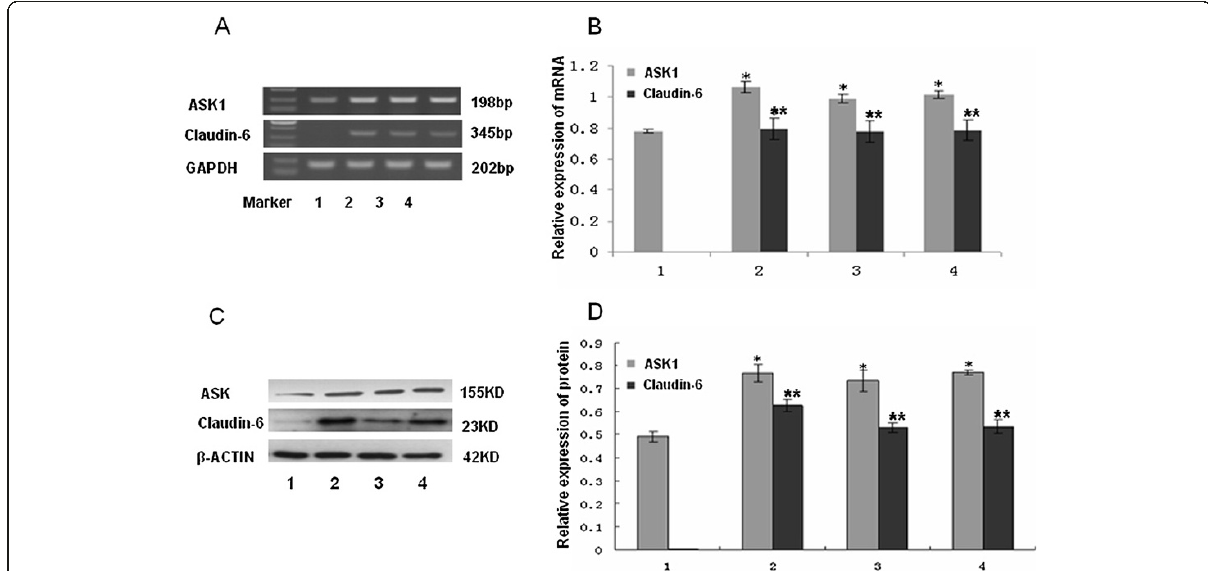
Figure 3 Correlation of claudin-6 and ASK1 in breast cancer cells. Line 1 is empty vector group; lines 2, 3 and 4 are three clone groups. ( A ) ( B ) RT-PCR assay examined the mRNA levels of claudin-6 and ASK1. ( C ) ( D ) Western blot assay detected claudin-6 and ASK1 protein expression. *,** P <0.05, vs. vector group. Results are means ± standard deviation for three independent